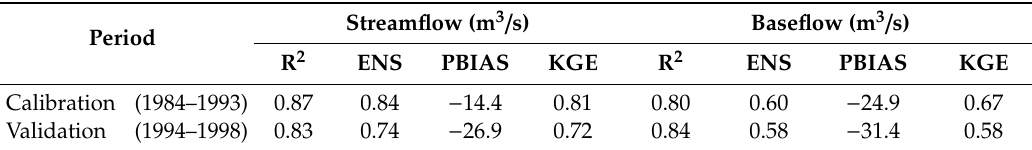
Figure 7. Observed and simulated baseflow of LEC watershed for calibration and validation period.